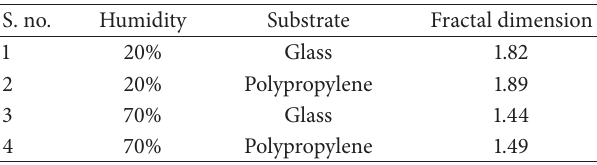
Table 1: Fractal dimension of sample in different substrates a differ- ent